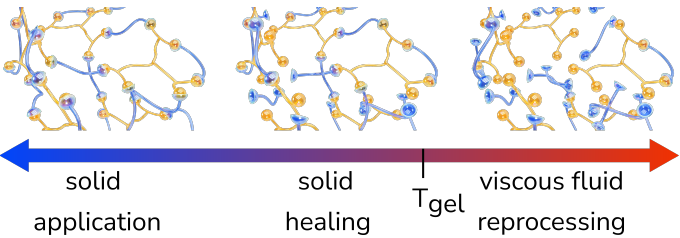
Figure 3. The self-healing polymer forms a reversible network. At room temperature, the polymer is solid and can be used for the application. It remains solid when heated mildly, which enables it to heal. Only when heated above its T gel , the polymer becomes a viscous fluid. Copyright 2022, Ellen